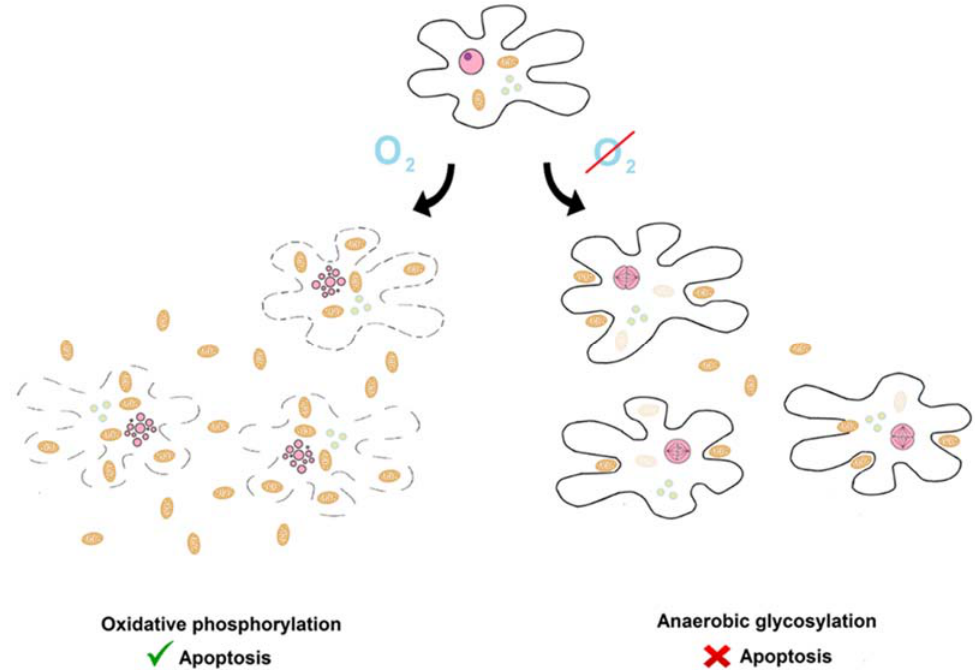
Figure 1. The Warburg and inverse Warburg effects in the ancestral state. There was an antagonistic relationship between prey (protomitochondrion, camel ovoids) and predators (protoeurkaryotes, black and doted lines). They killed each another. There was a dynamic equilibrium. Aerobic conditions caused shift of balance towards protomitochondrions and protoeukaryotes were killed (inverse Warburg effect). In contrast, under anaerobic conditions, the struggle was won by protoeukarytes. Other graphical elements: pink ovals—nucleus or fragmented nucleus, greenish circles—vesicles.